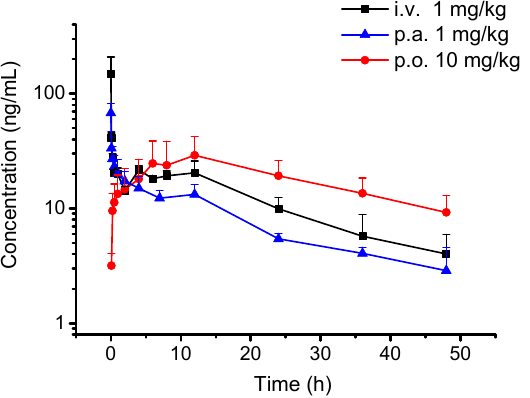
Table 2. Matrix effects and recovery of CEP in rat plasma ( n = 6).